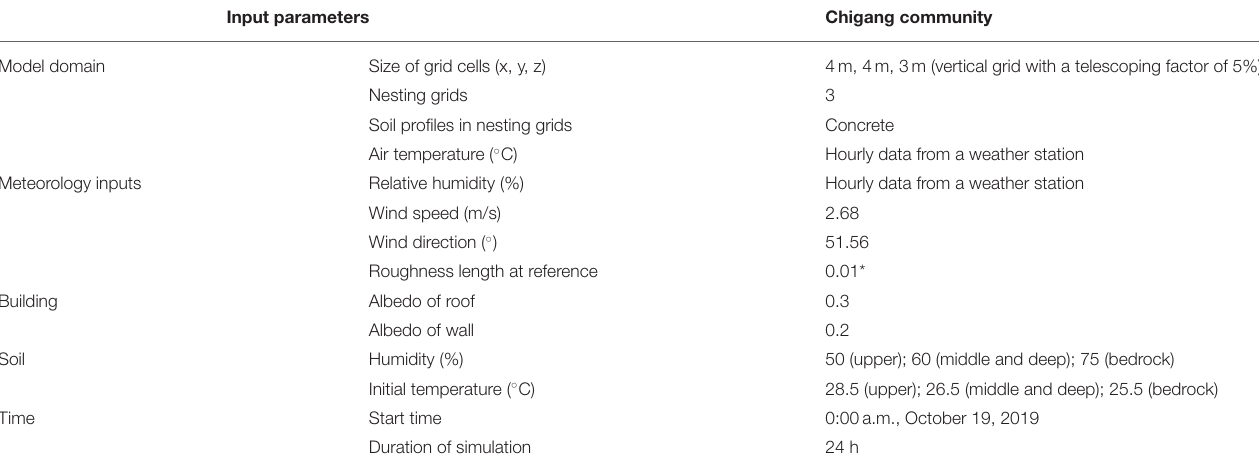
TABLE 1 | Chigang community modeling file and configuration